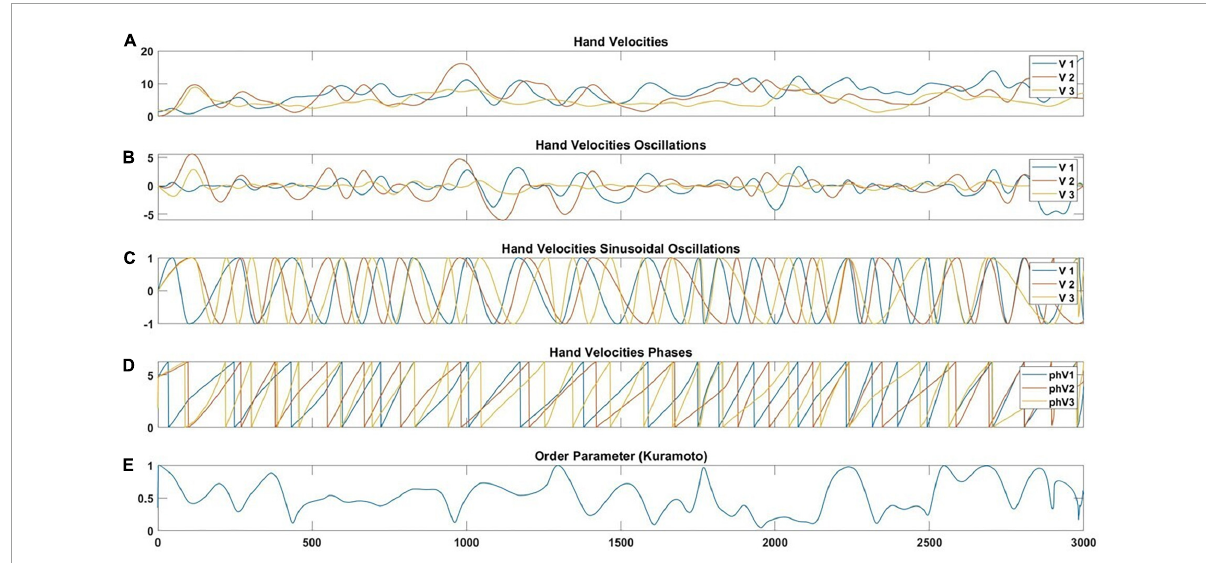
FIGURE5 Illustration of the velocity pre-processing steps. Taking the raw signal (A) , implementing local detrending (B) , and the undulatory part of the signal (C) are used to extract phases with the Hilbert Transform (D) and implementation of the Kuramoto order parameter (E) . Within the graph legend, the V1, V2, and V3 correspond to the velocity of participant 1 (V1), participant 2 (V2), and participant 3 (V3). In addition, the phV1, phV2, and phV3 correspond to the we extracted phase velocities of participant 1 (phV1), participant 2 (phV2), and participant 3